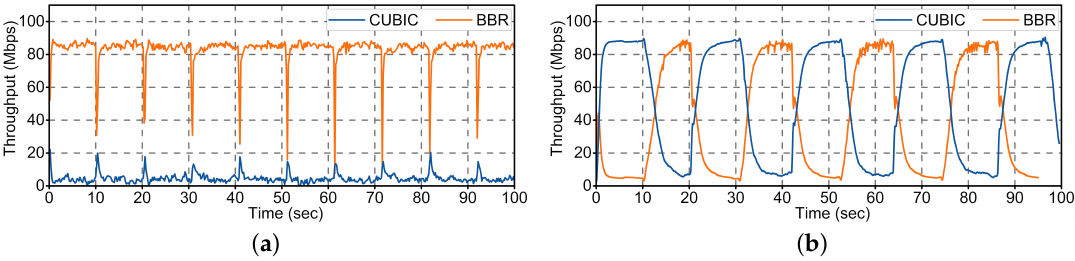
Figure 5. Throughput between BBR and CUBIC: ( a ) shallow buffer (0.8 BDP); and ( b ) deep buffer (5 BDP).